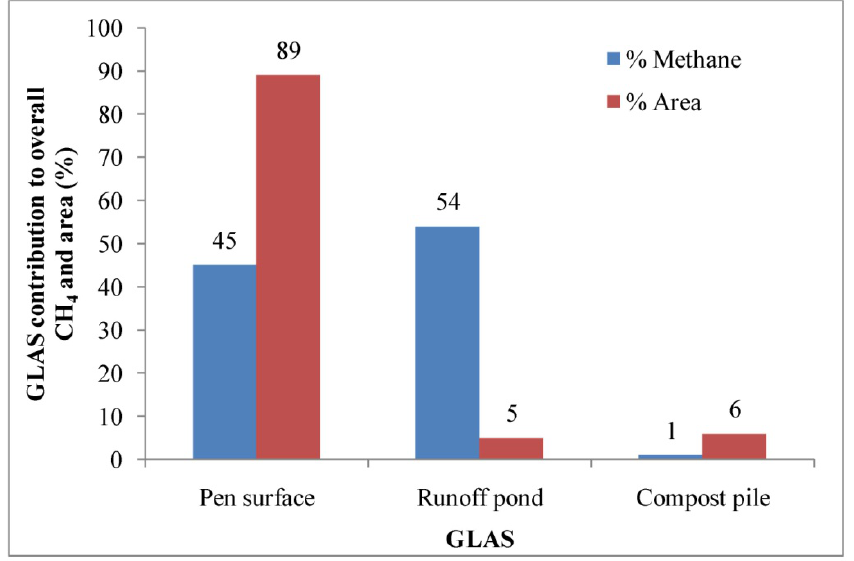
ER and area at the 4